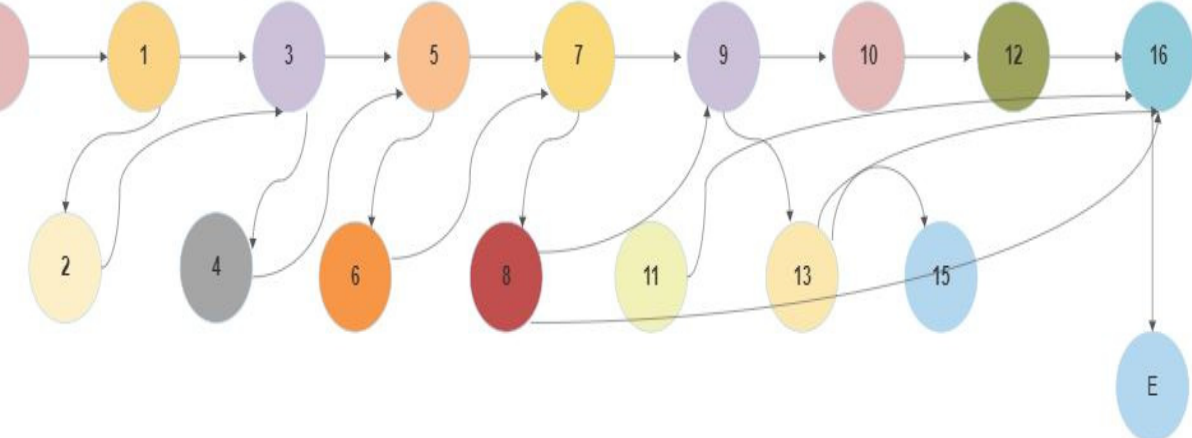
Figure 2. Control flow graph of the proposed model. Numbers denote the node numbers, Source (S) and End node (E).